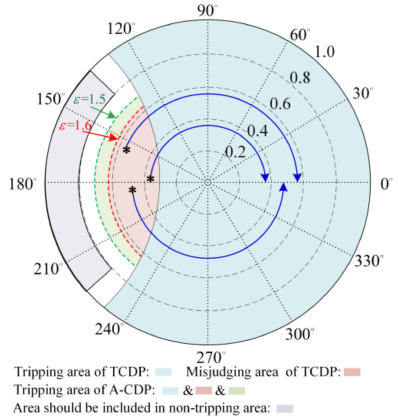
Figure 6. Action characteristics of ACDP and TCDP in active distribute